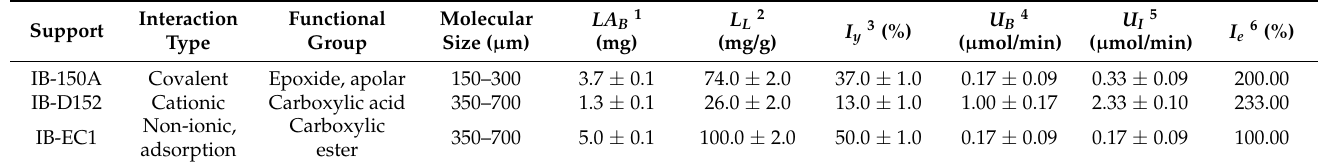
Table 3. Lipolytic activity of AA-ANL immobilized onto three polyacrylic supports, as well as the characteristic features of each support (data achieved from